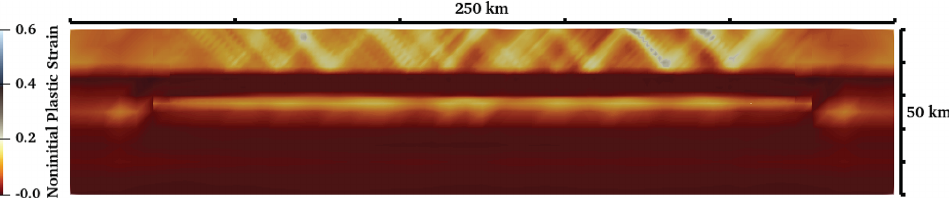
Figure B6. Cross section at y = 240km, showing the non-initial plastic strain attribute through 10Myr of the model run. This section is located 10km into the strong domain, proximal to the boundary with the weak domain. See Fig. 4b for a 10Myr snapshot. Screenshot taken at 10Myr.